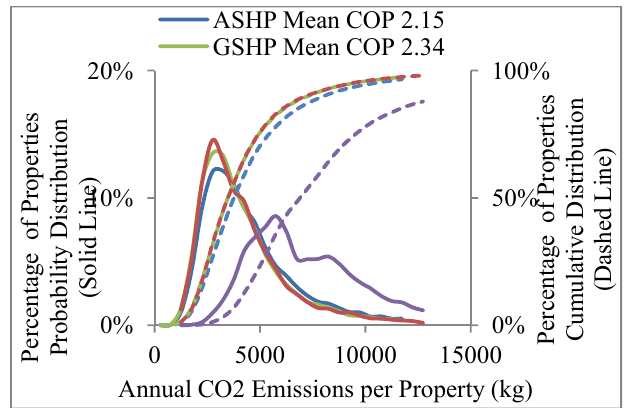
Figure 5. Annual CO emissions for heat pumps operating at field study levels of performance. 2